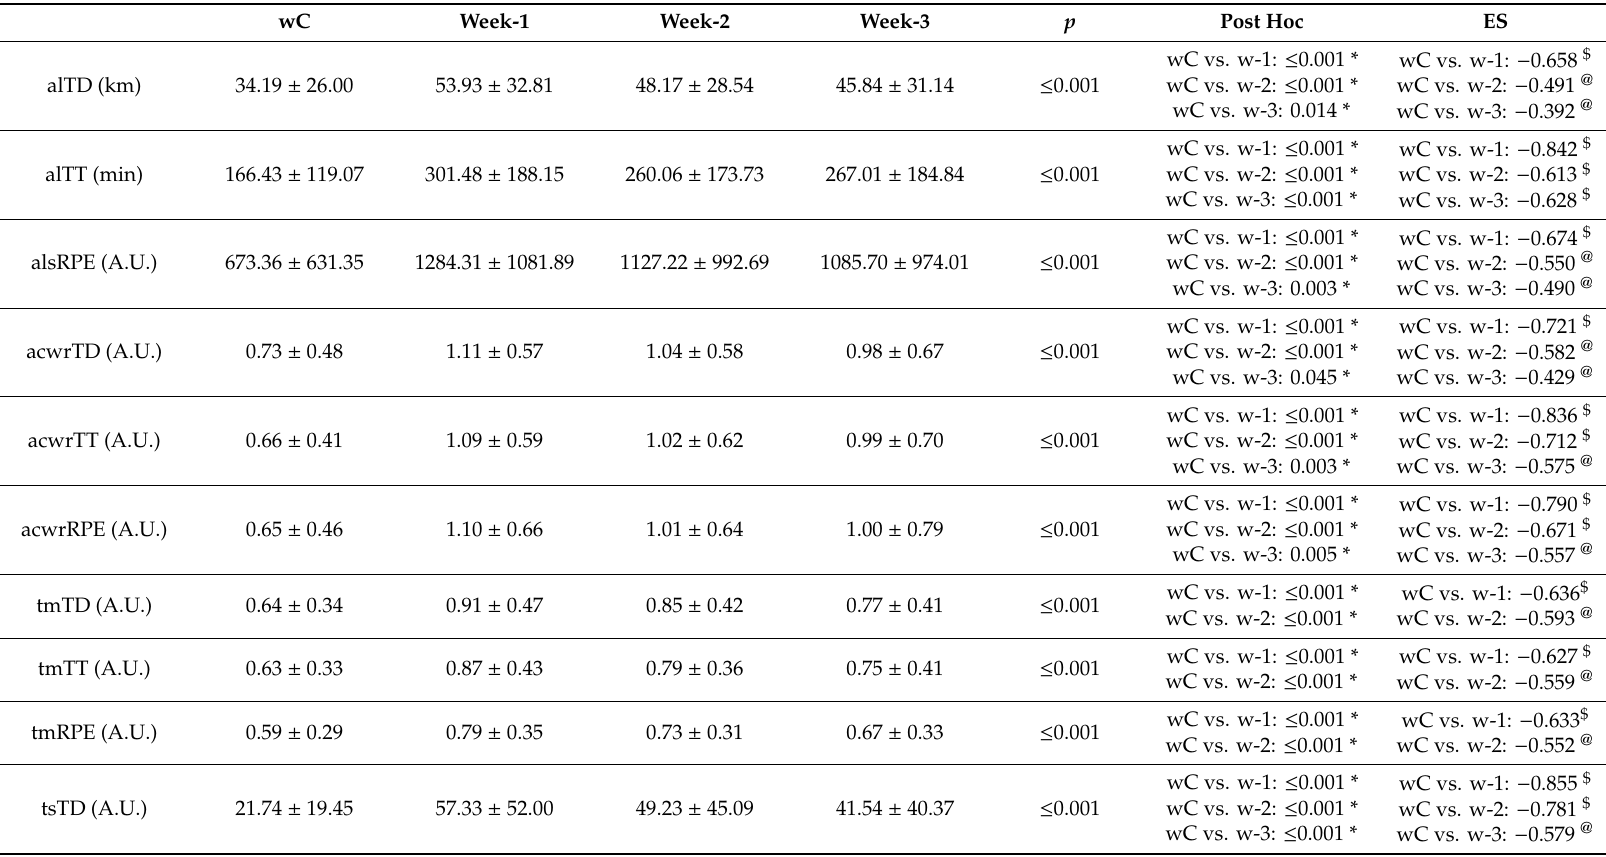
Table 3. Descriptive statistics of workload measures before long trail (LT)